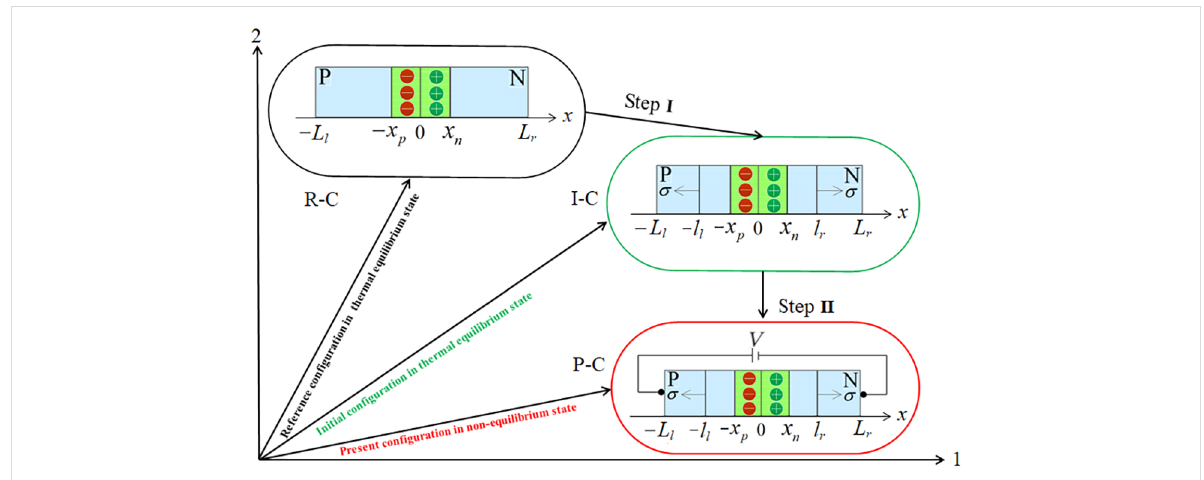
Figure 1: Three configurations of a piezoelectric p–n junction: 1) R-C stands for the piezoelectric p–n junction in the reference configuration without mechanical loadings and any electric bias voltage; 2) I-C stands for the p–n junction in the initial configuration exposed to mechanical loading